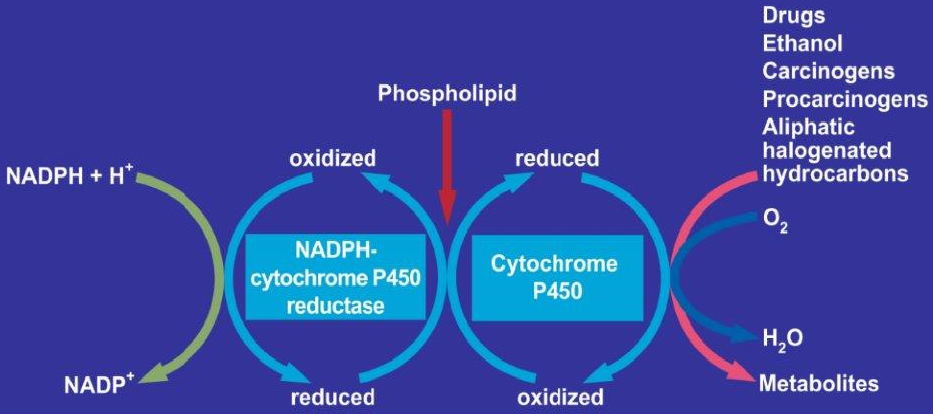
Figure 2. MEOS and other exogenous substrates. This schematic sequence of events at the microsomal level was expanded and modified from a figure previously published in an open-access journal [13].